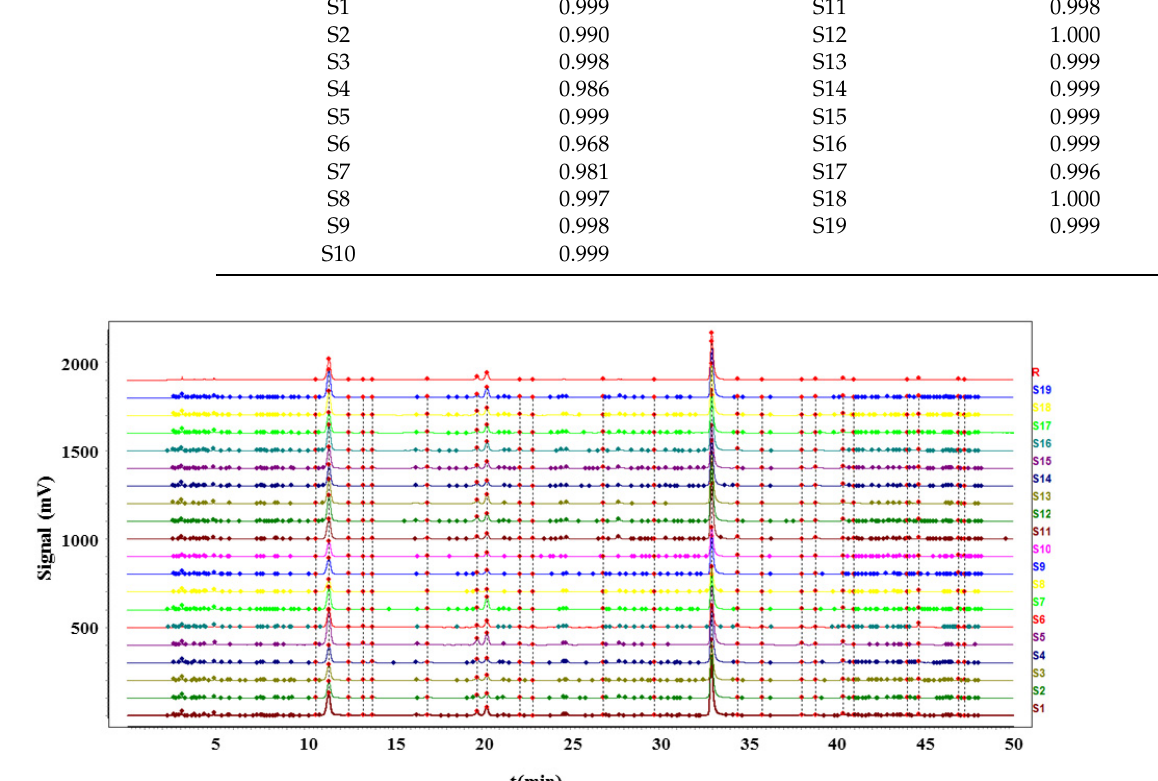
Figure 2. Fingerprint overlays of 19 batches of dandelion.